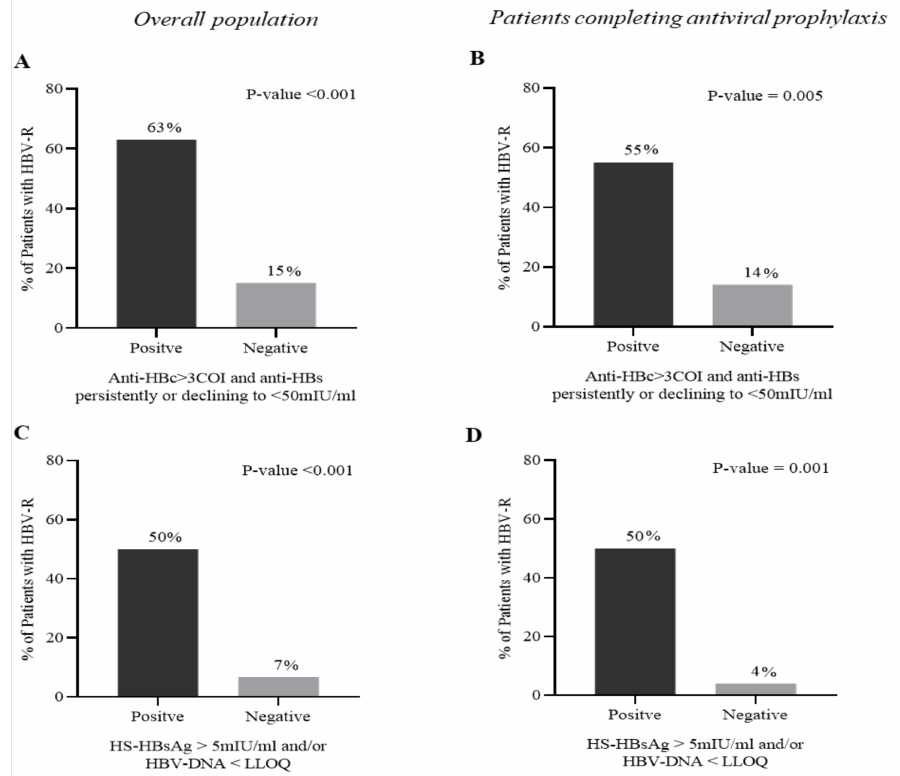
Figure 2. The combined usage of accurate HBV markers can predict the occurrence of HBV reacti- vation. The histogram reports the occurrence of HBV-reactivation in patients positive/negative to anti-HBc > 3COI + anti-HBs < 50 mIU/mL ( A , C ) and in patients positive/negative